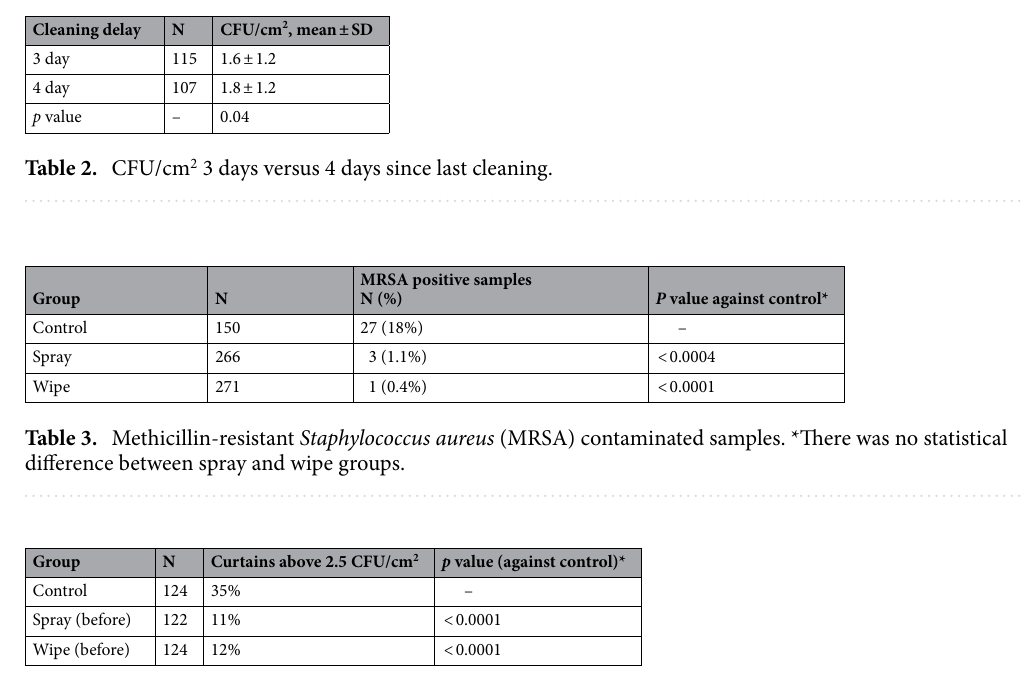
Table 4. Curtains above 2.5 CFU/cm 2 . *There was no statistical difference between spray and wipe